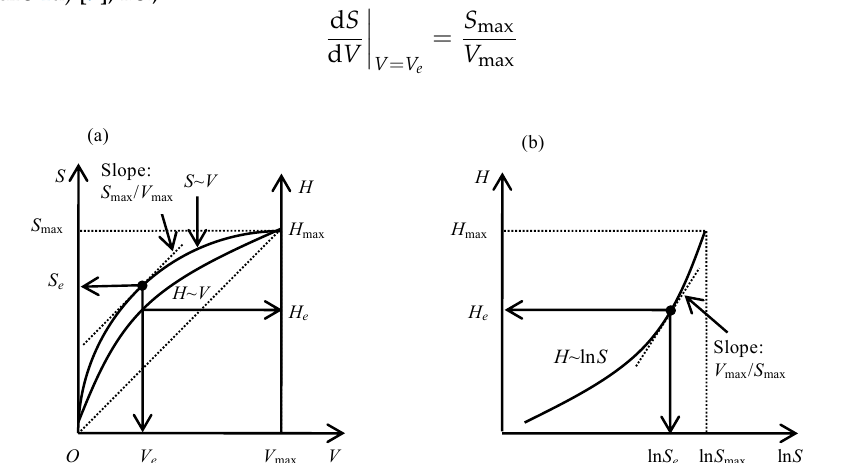
Figure 1. Sketch of ( a ) the lake surface area method [9] and ( b ) the simplified lake surface area method.